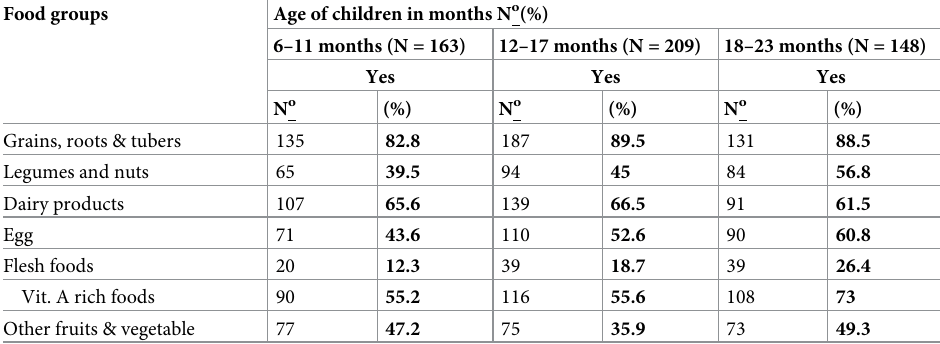
Table 3. Types of food groups given during the previous day according to age of the child among children aged 6–23 months, Shashemene, 2020 (N = 520). Food